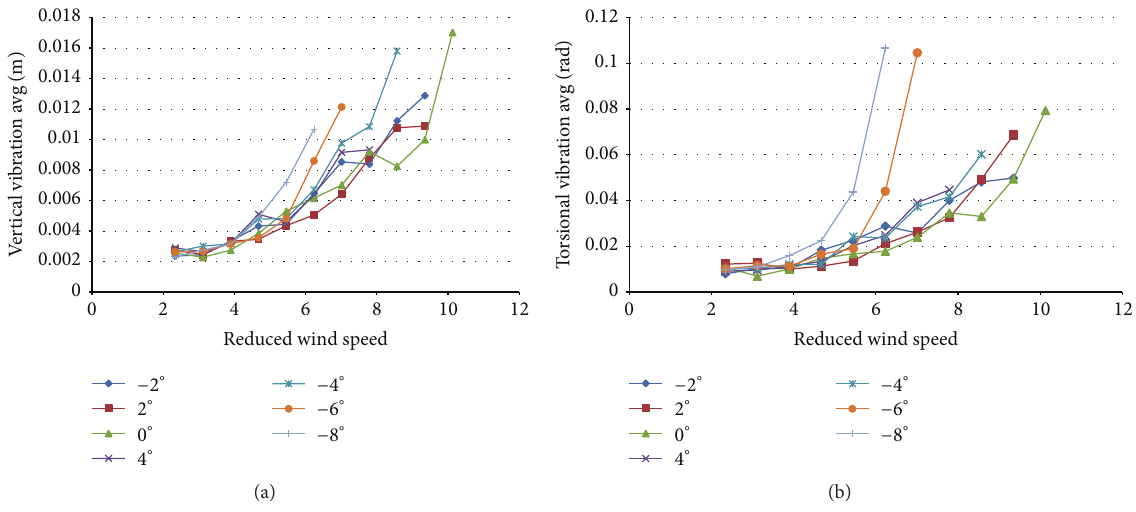
Figure 5: (a) Vertical average response and (b) torsional average